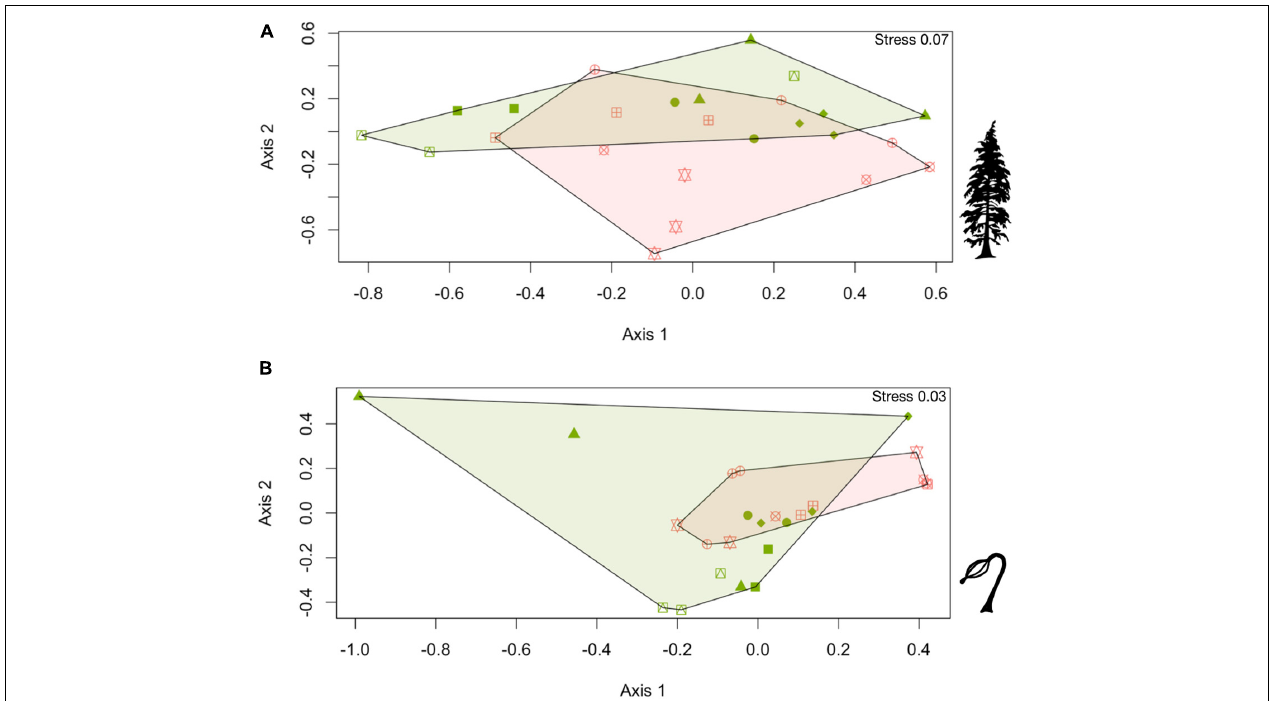
FIGURE 3 | nMDS plots comparing control (pink polygons) and habitation (green polygons) sites community composition for (A) adult tree communities, and (B) regeneration communities. Each point represents a plot, with plots of similar shapes being from the same site. The stress of each plot is denoted in its right